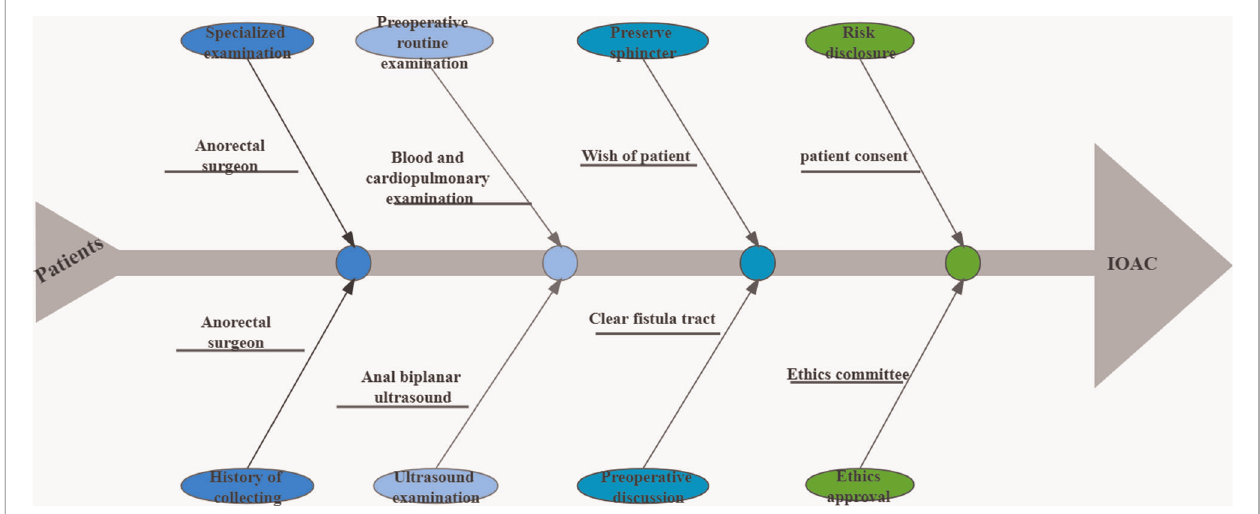
FIGURE 2 | A fl ow-chart from a patient visit to the surgery. The general course of a patient from a visit to the surgery contains preoperative examination, risk noti fi cation, and ethical